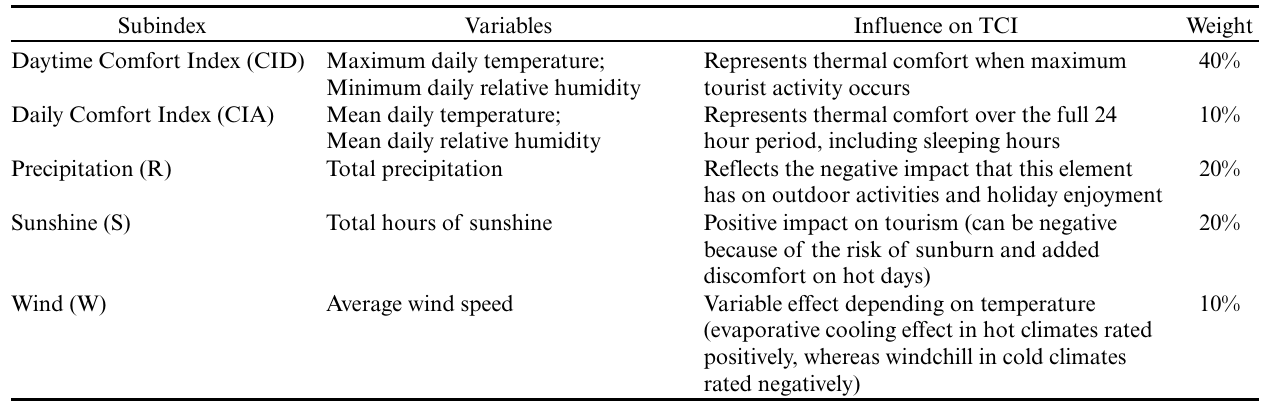
Table 1 . Components of the Tourism Climate Index (TCI; ECLAC 2011). Subindex